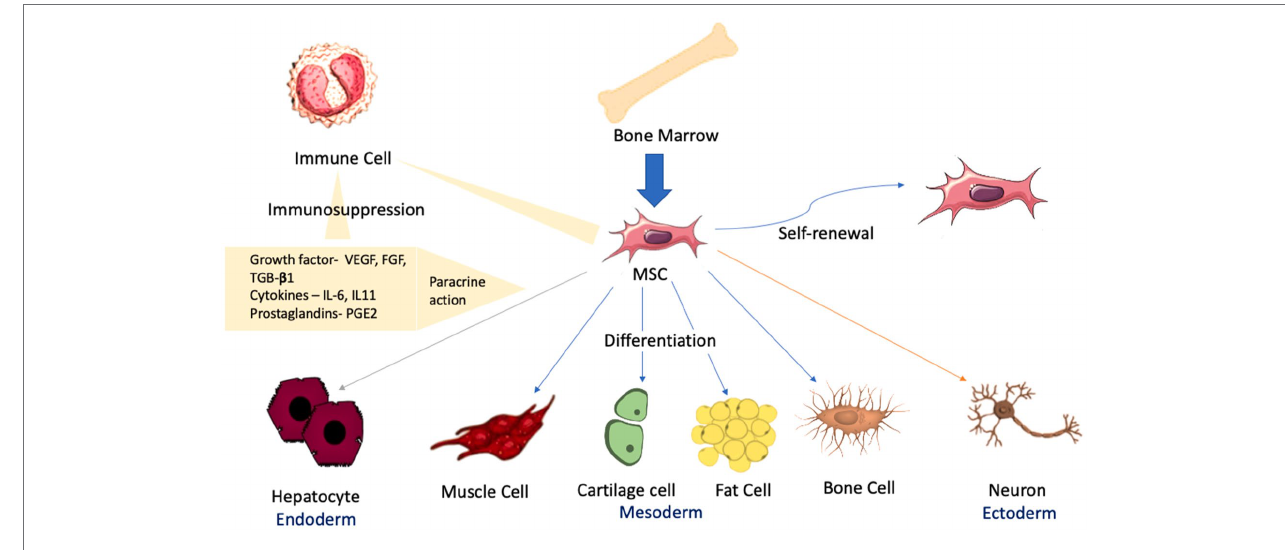
FIGURE 1 | The differentiation of MSCs into various organs and